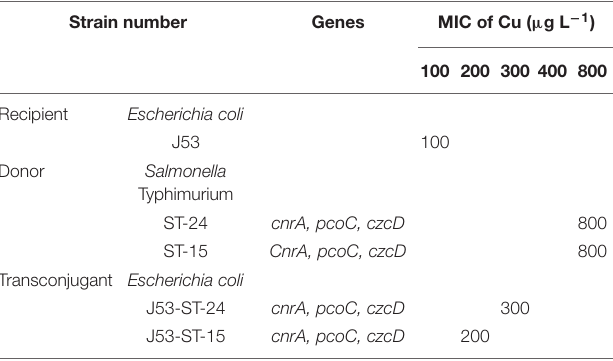
TABLE 7 | Transconjugation of metal resistance genes from Salmonella Typhimurium to Escherichia coli J53.